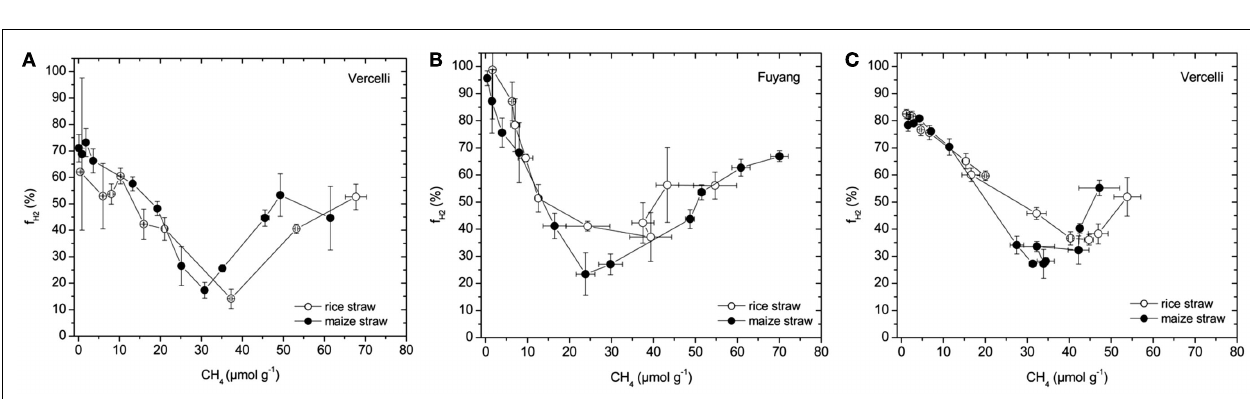
acetate was consumed, and then increased again ( Figure 7 ).